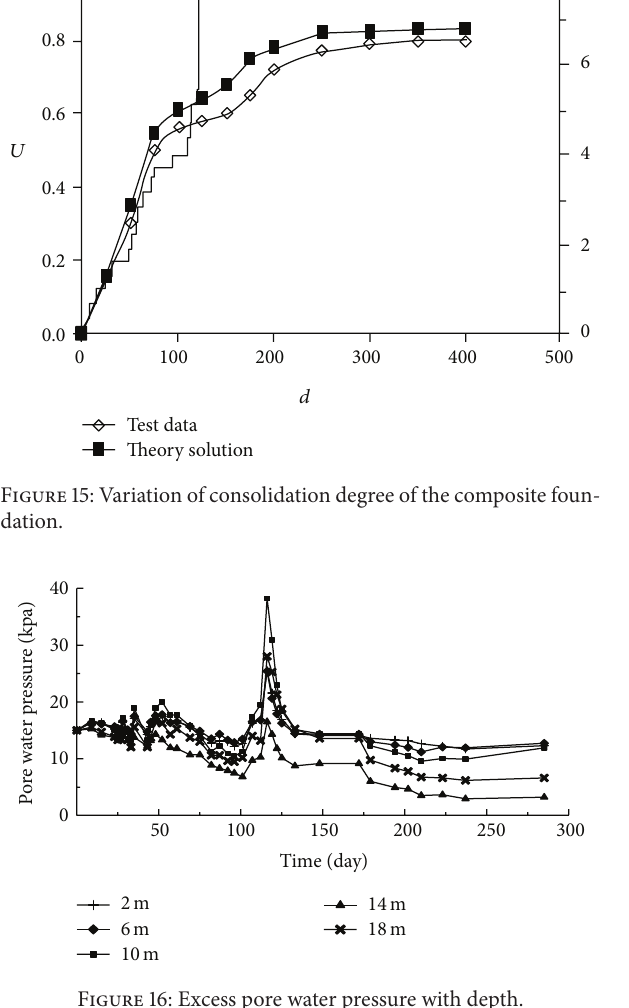
Figure 16: Excess pore water pressure with depth.